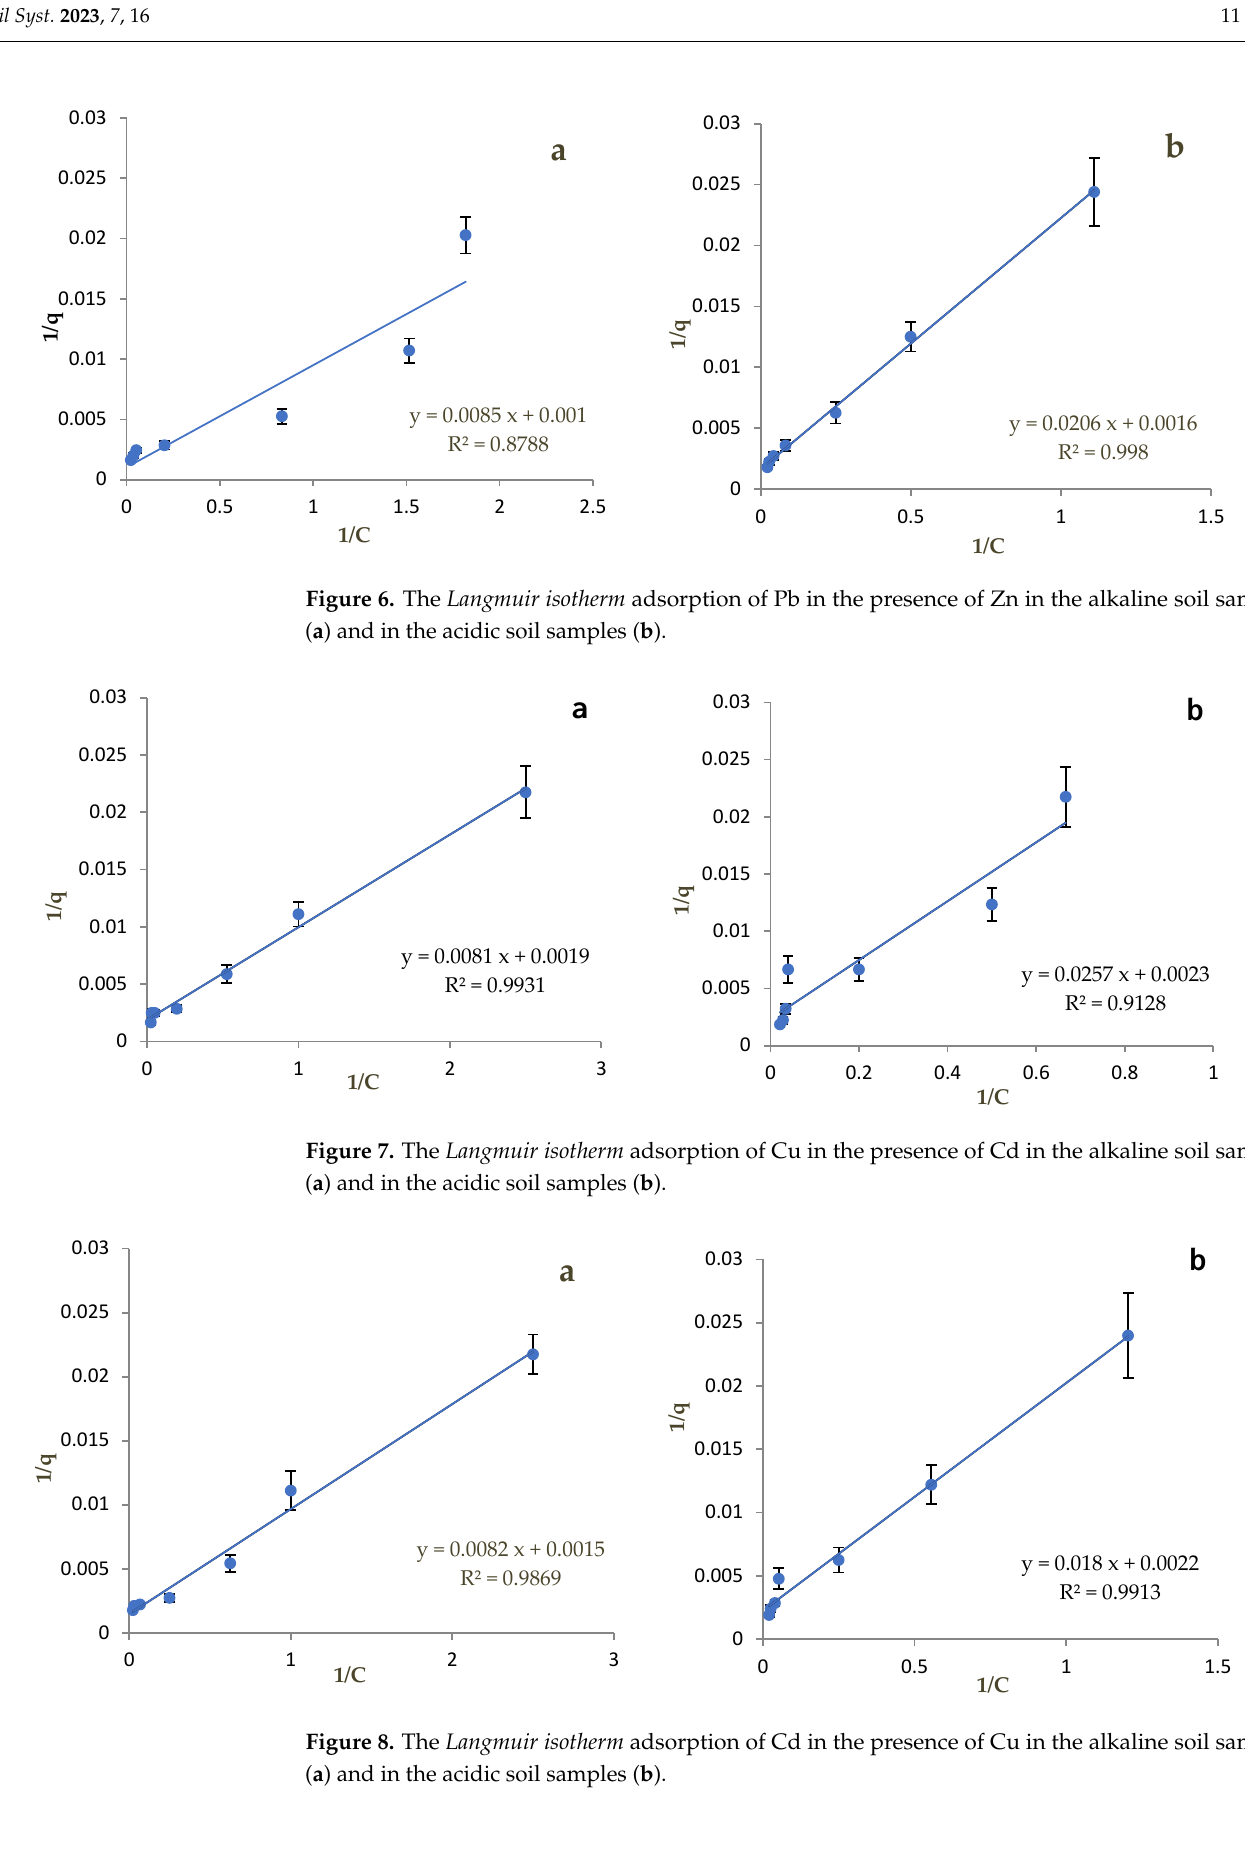
Table 3. Langmuir isotherm absorption parameters for Zn and Pb and for Cu and Cd during bime- tallic systems of both studied soils.